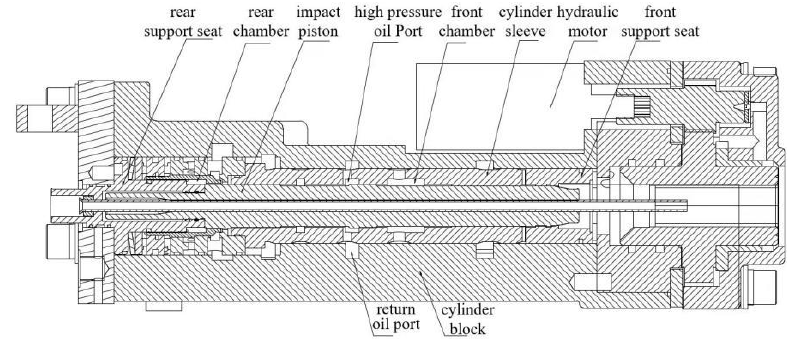
Figure 1. Impact mechanism of YG45 hydraulic rock drill.